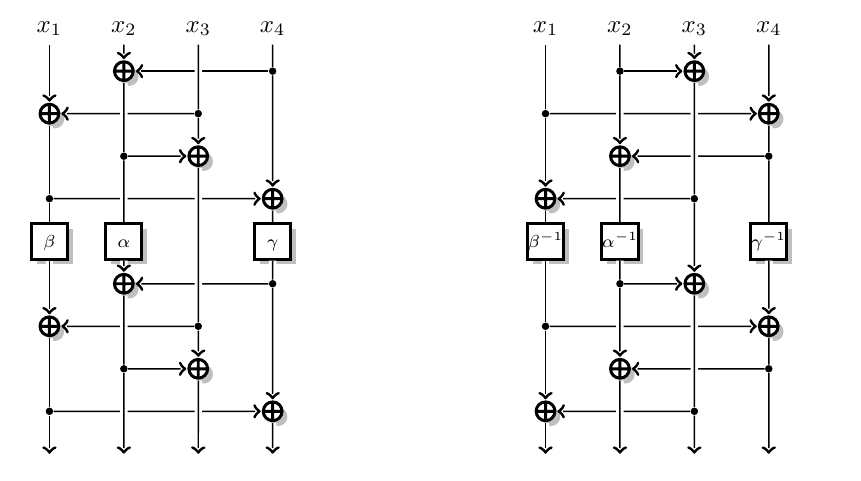
. Figure 2: 4 × 4 MDS with depth 5: M 8 , 3 4 , 5